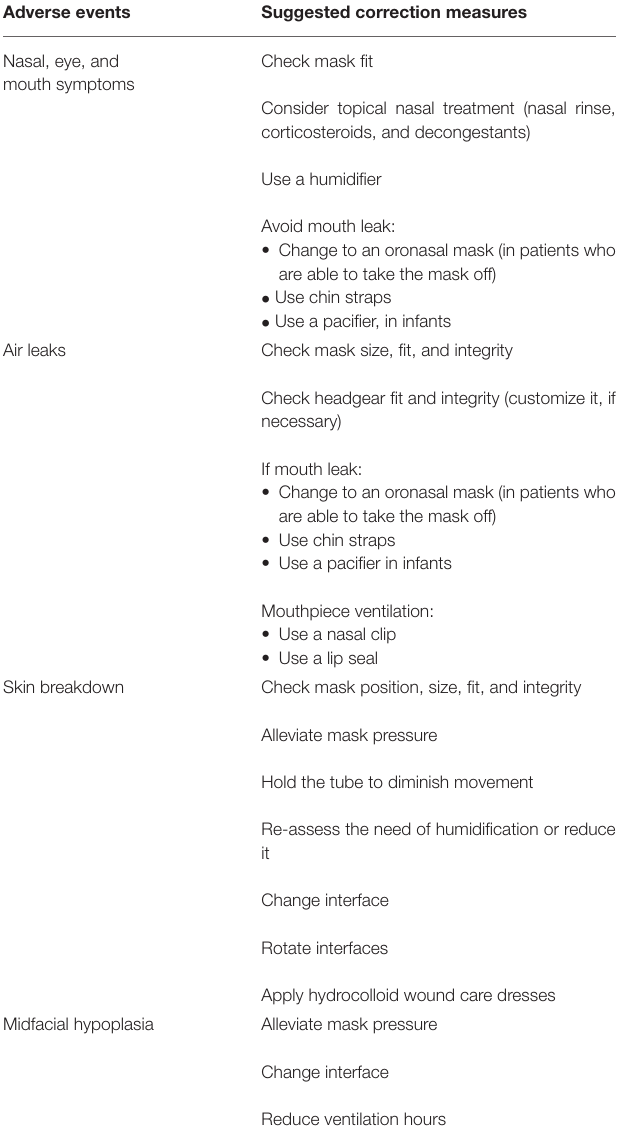
TABLE 2 | Interface-related adverse events and suggested correction measures. Adverse